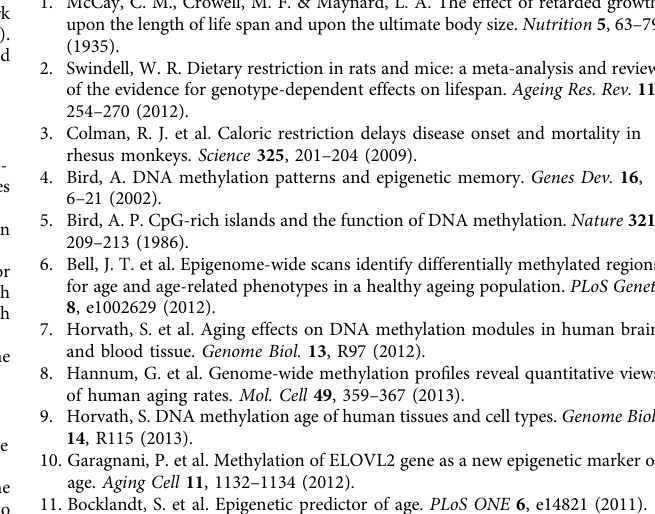
Table 21. The PCR conditions for ampli fi cation (using Telomere-1 primers and 36B4 primers) were: 95 °C for 10min followed by 40 cycles at 95°C for 15 s, and 60 °C for 1min. To amplify telomere by Telomere-2 primers, the same conditions were used except annealing temperature as 54°C. The PCR conditions for HBG1 gene ampli fi cation were: 95°C for 10 min followed by 40 cycles at 95°C for 15 s, and 58°C for 1 min. The quantitative PCR was performed using a StepOne Real- Time PCR